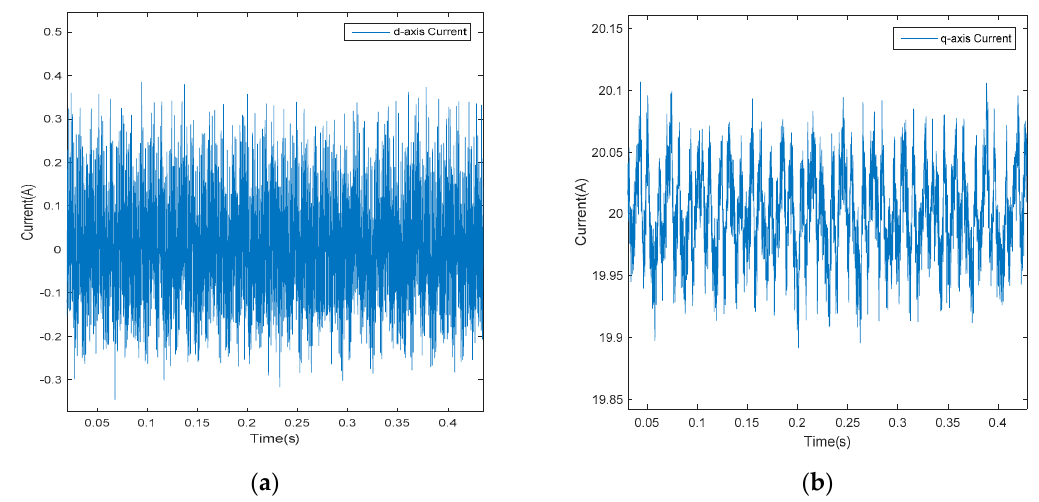
Figure 12. Experimental results after adopting the state observer, ( a ) d -axis current and ( b ) q -axis current.